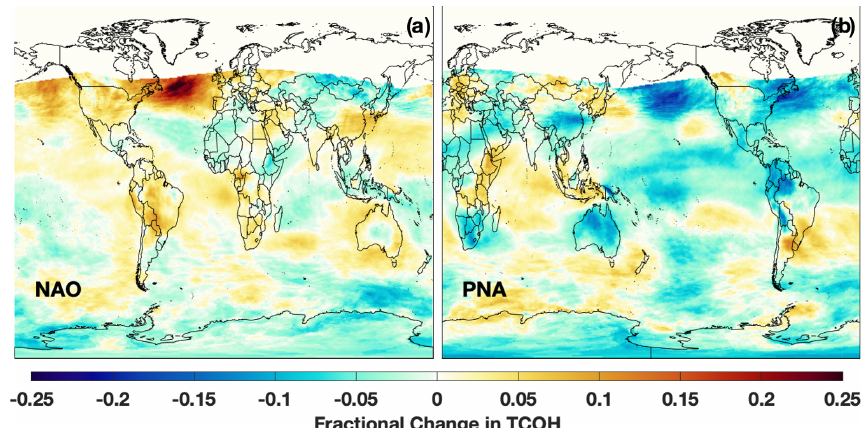
Figure 20. Fractional change in TCOH for positive phases of the NAO (a) and PNA (b) , defined as having an index greater than 0.4, as compared to neutral events (index between − 0.4 and 0.4). Note that, for emphasis, the x axis is shifted in panel (b) to center the map over the Pacific Ocean.